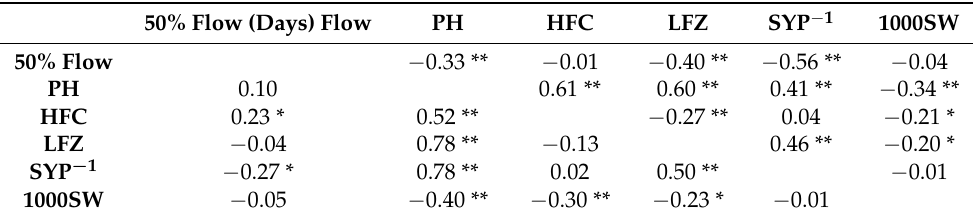
Table 2. Phenotypic correlation coefficients among traits in the F 2 - generation, Sohag2000/Shand3 (pop1) above and Int526/int688 (pop2) population below diagonal.